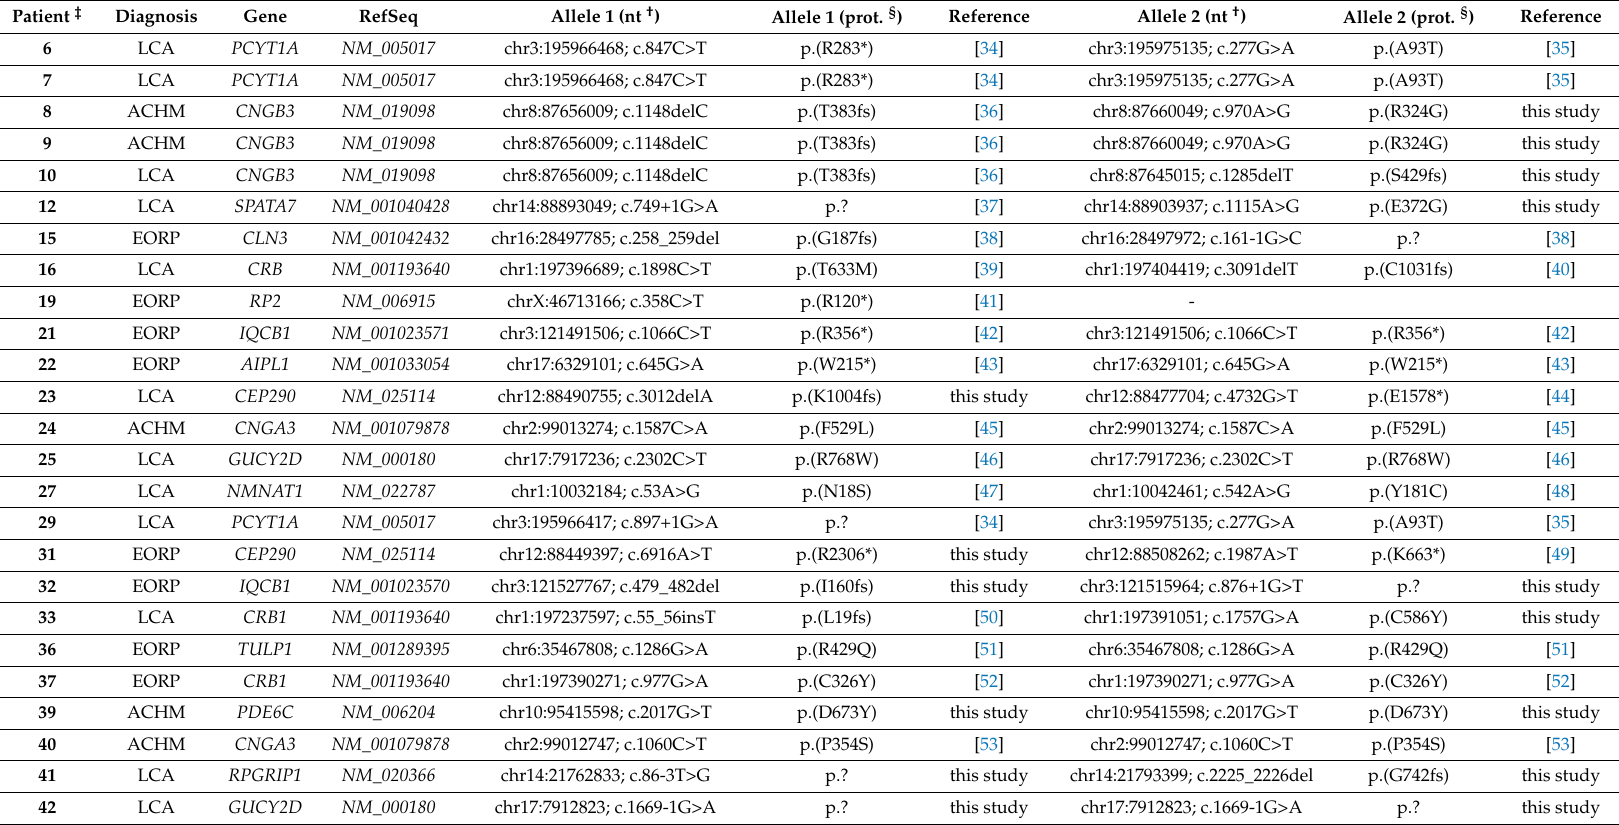
Table 1. Summary of the genetic findings in the analyzed